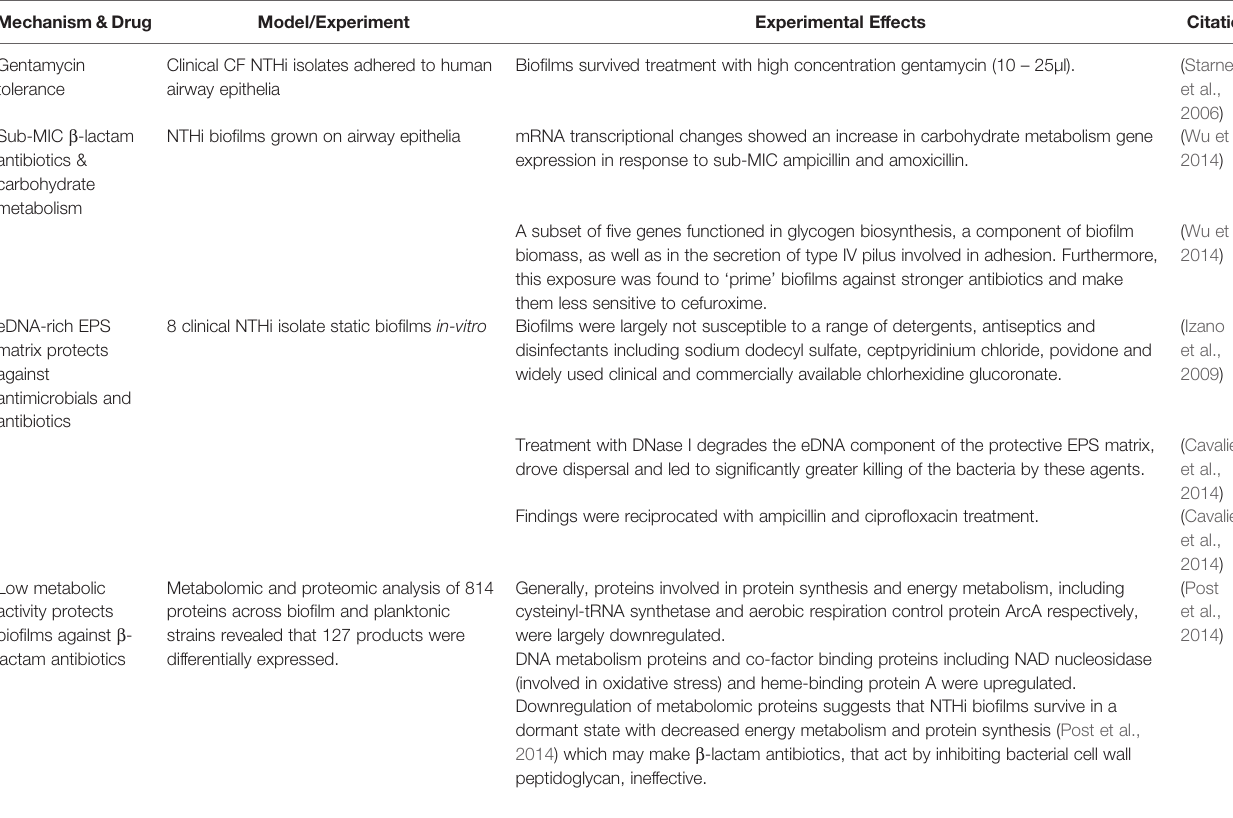
TABLE 3 | Summary of NTHi Bio fi lm Antibiotic Resistance & Tolerance